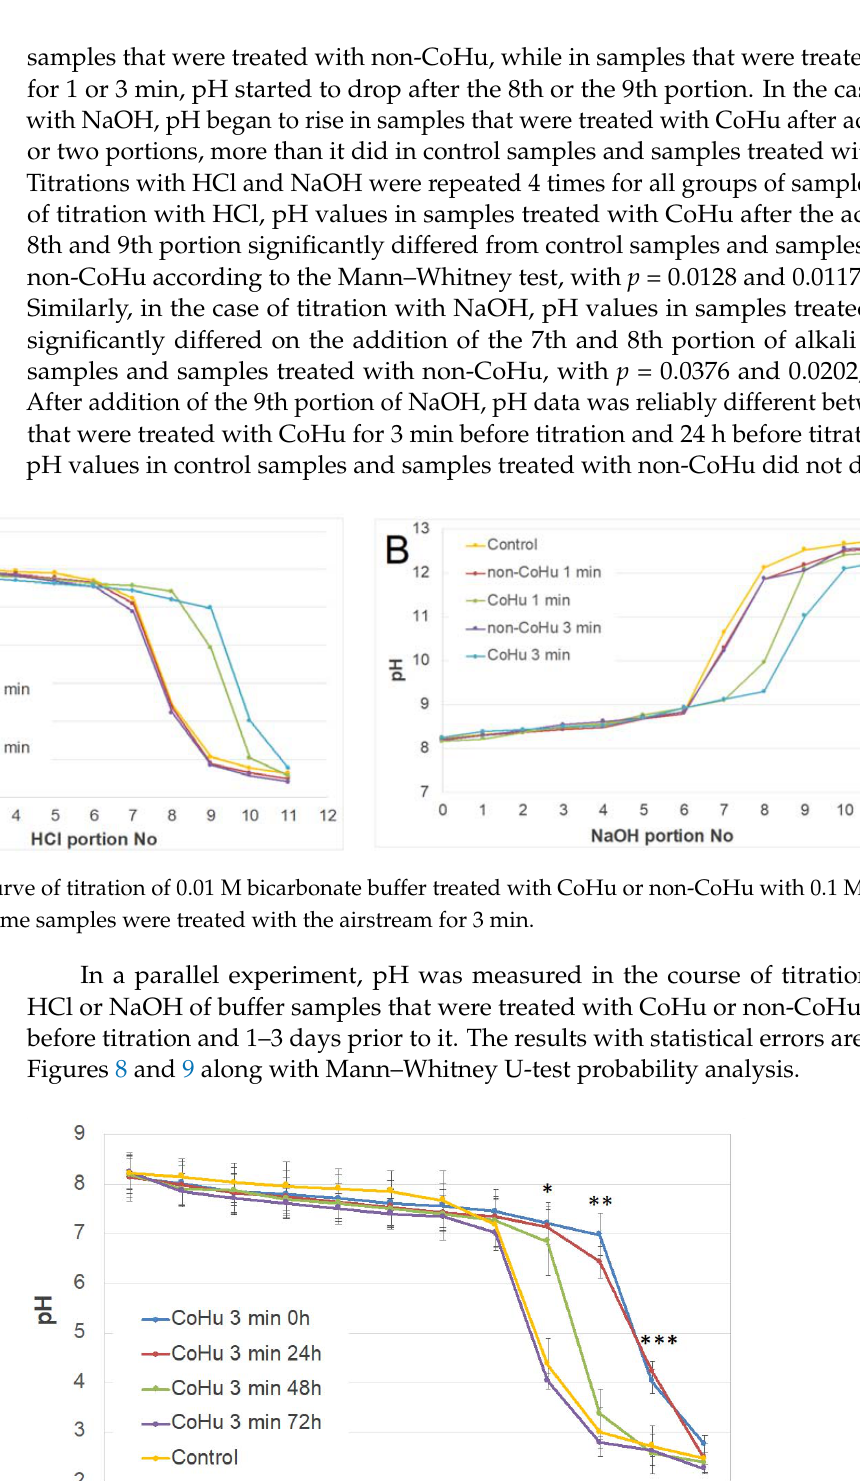
8 of 15 Figure 5. ( A ) Senezhskaya water dielectric constant scattered data in samples treated with CoHu and non-CoHu. ( B ) Fisher pairwise comparisons for dielectric constant measurements in Senezhskaya natural water. CIs are confidence in- tervals. If an interval does not contain zero, the corresponding means are significantly different. Figure 6. ( A ) BioVita water dielectric constant scattered data in samples treated with CoHu and non-CoHu. ( B ) Fisher